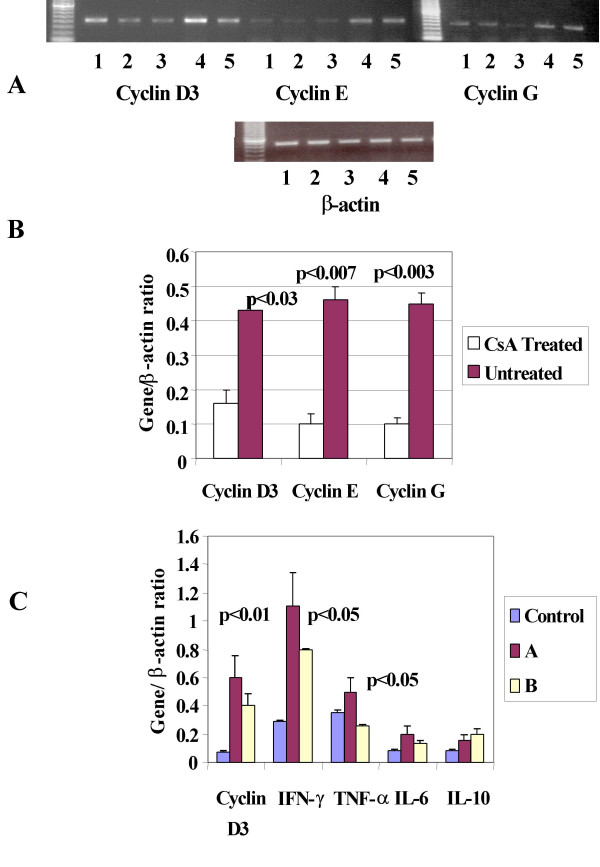
In vitro and in vivo mRNA expression of Cyclins relates to alloimmune activation: A: Cyclins; D3, E and G and β-actin mRNA expression in lymphocytes isolated from spleens of rat heart transplant recipients. Untreated (lanes 4,5), CsA treated (lanes 1,2,3). B: Mean ± SEM of the ratio cyclins with β-actin, p values are calculated between densitometric numbers of untreated and CsA treated transplant recipient. C: Cyclin D3 and pro-inflammatory cytokines mRNA expression in lymphocyte from MLR assay using stimulants from donor strain with responders from donor strain (Control) untreated rejecting transplant recipients (A) and CsA treated non rejecting transplant recipients (B). The p values represent the statistical significance between ratio of densitometric numbers for each gene with β-actin from untreated (Group A) vs CsA (Group B) treated transplant recipients.